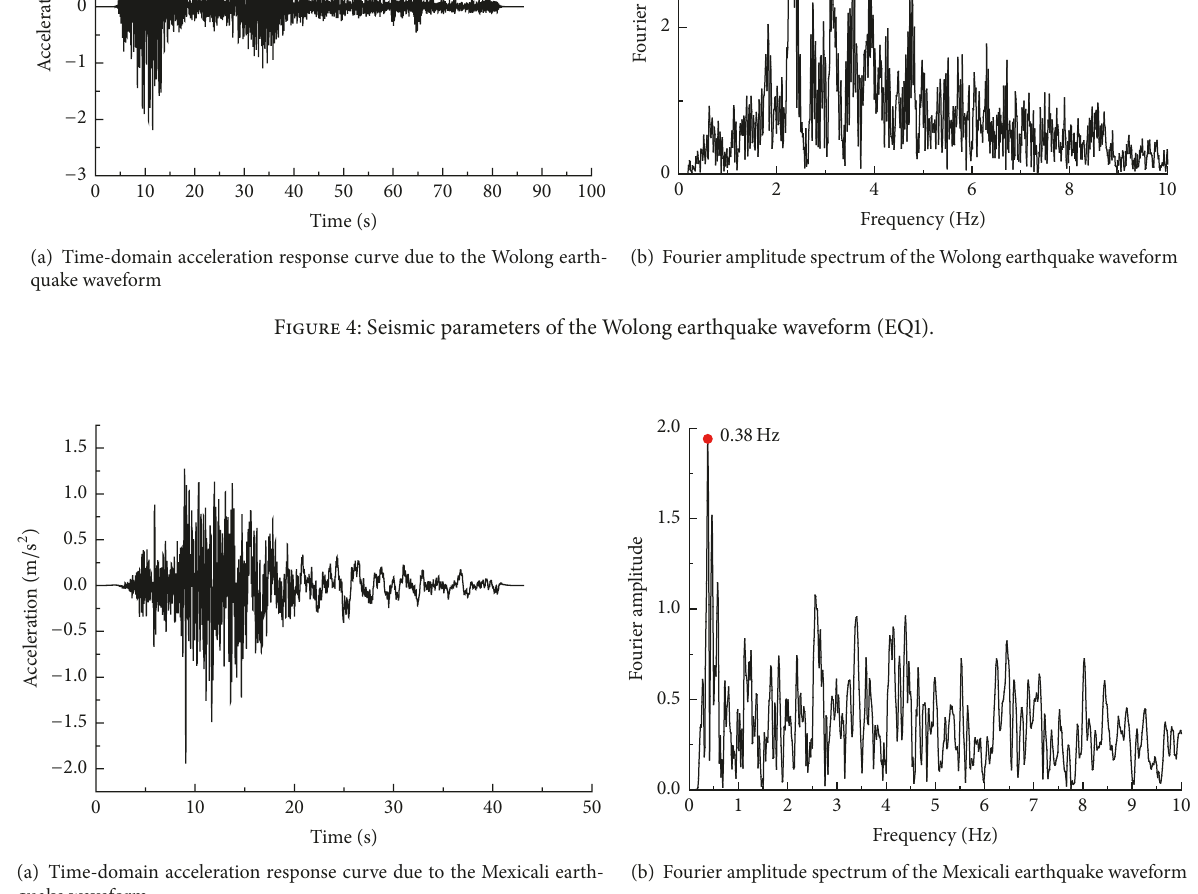
Figure 5: Seismic parameters of the Mexicali earthquake waveform (EQ2).